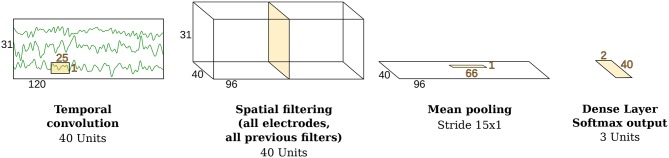
Architecture of the ConvNet. Modified from Schirrmeister et al. (2017) with the permission of the authors.